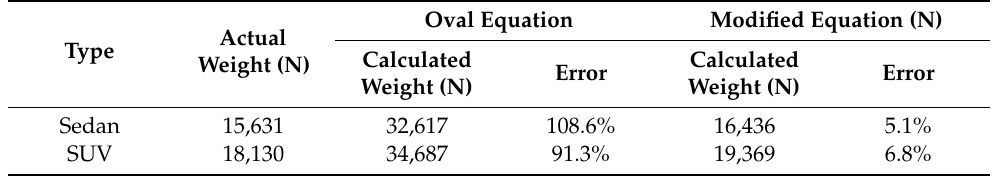
Table 6. Gross weight identification results for passenger